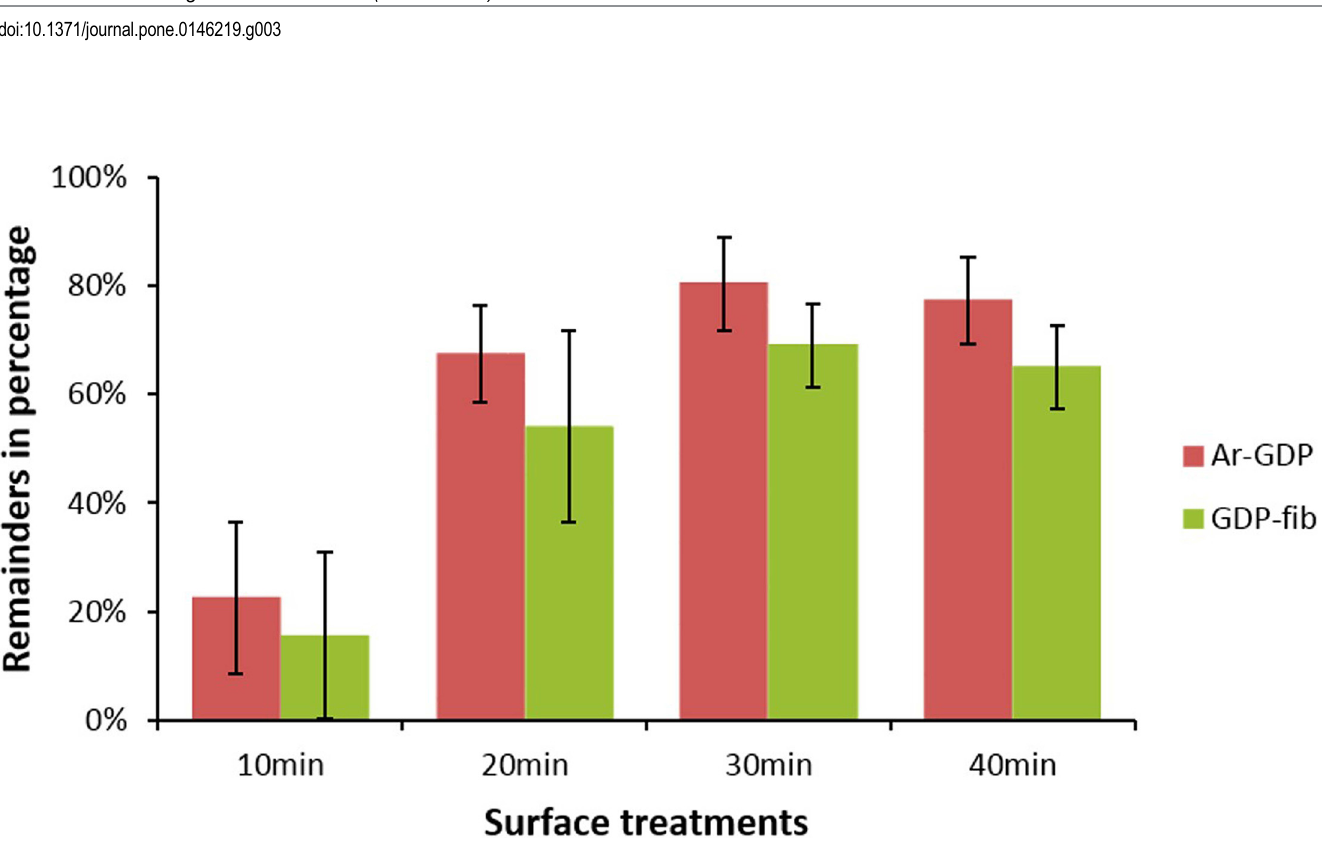
Fig 4. Blood coagulation of Ar-GDP and GDP-fib samples was expressed as percentage and compared to that of the blank plate (100%). There was no significant difference between two groups.